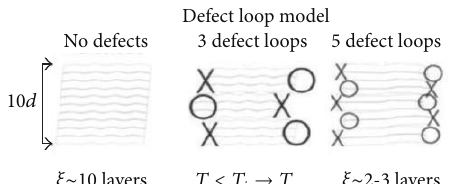
Figure 13: Sketch of the dislocation model that conserves layer spacing. X marks where a loop enters the page and ⃝ where it emerges from the page. Packets of layers associated with each loop are decorrelated ROM layer packets associated with other loops. As 𝑇 → 𝑇 𝑔 , more dislocation loops form leading eventually to no correlated layers in the sample, or, in other words, nematic